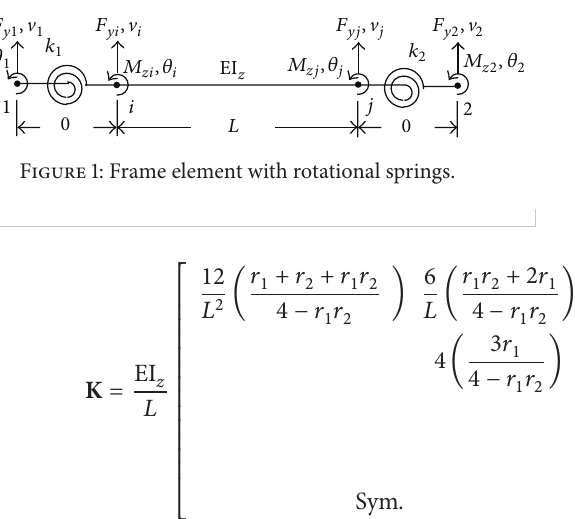
the member ends, the values for 𝑟 1 and 𝑟 2 are sought using the numerical updating procedure.